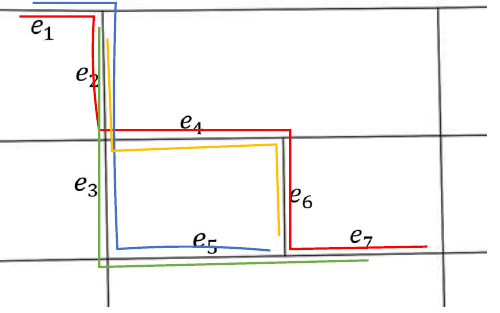
Figure 4. Four trajectories in the road network: P 1 → 7 = { e 1 → e 2 → e 4 → e 6 → e 7 } (red line), P 1 → 5 = { e 1 → e 2 → e 3 → e 5 } (blue line), P 2 → 7 = { e 2 → e 3 → e 5 → e 7 } (green line) and P 2 → 6 = { e 2 → e 4 → e 6 } (yellow line).